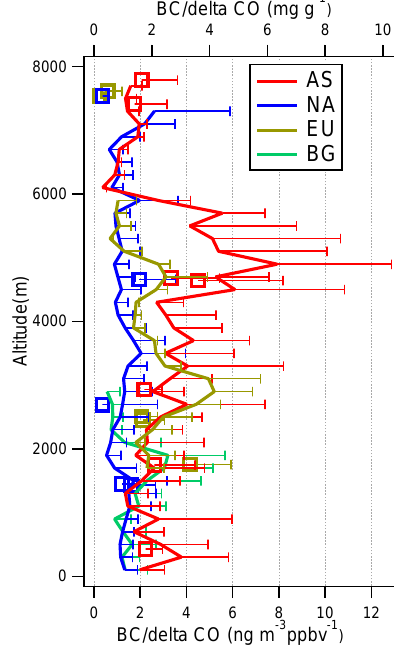
Figure 10. BC /(cid:49) CO measured during ACCACIA for different air mass origins, with the lines and square markers showing the ratio for vertical profiles and plumes respectively. The bars show the + σ